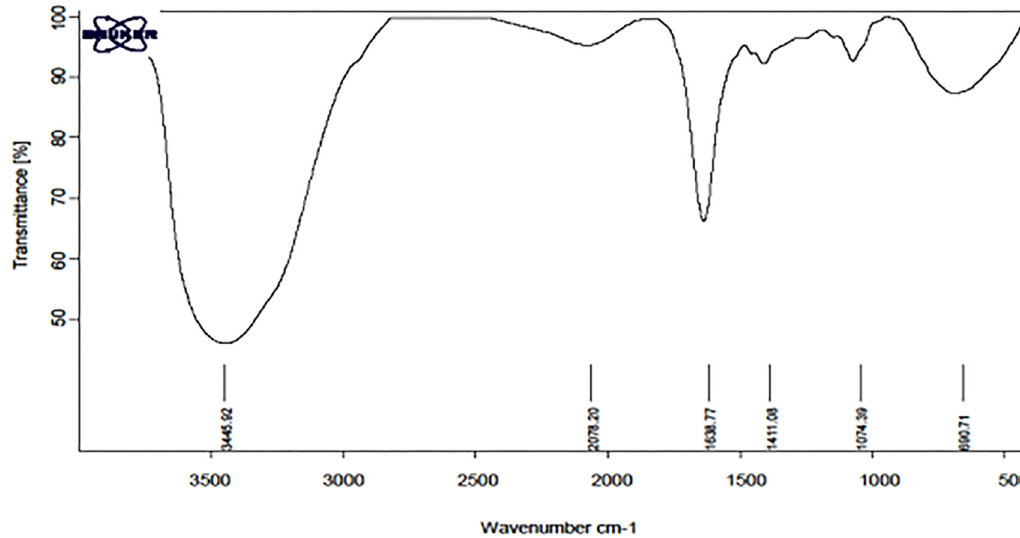
Figure 1: FT - IR spectrum of the prepared red pepper extract.